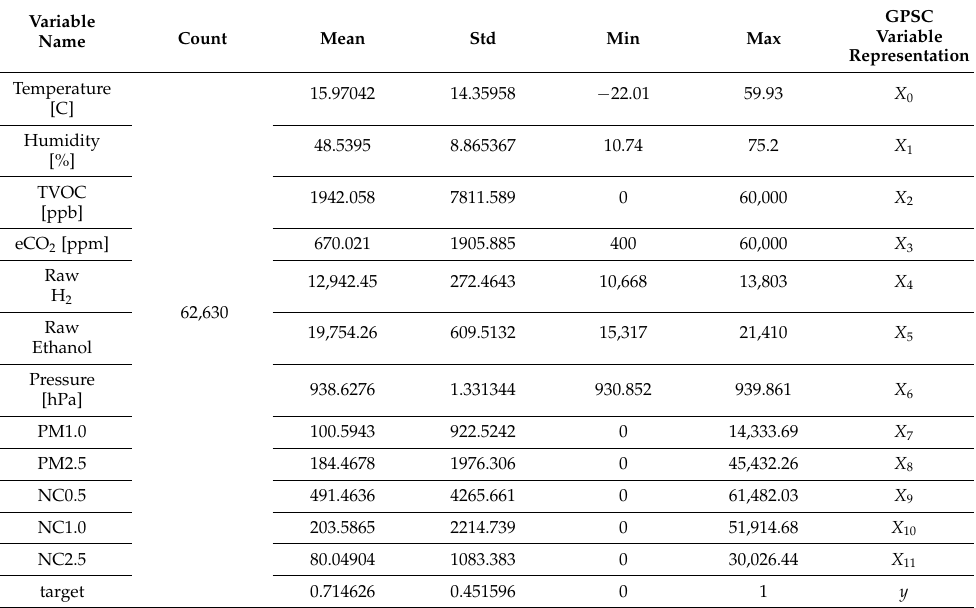
Table 1. The initial statistical analysis of the original dataset with variable names used in